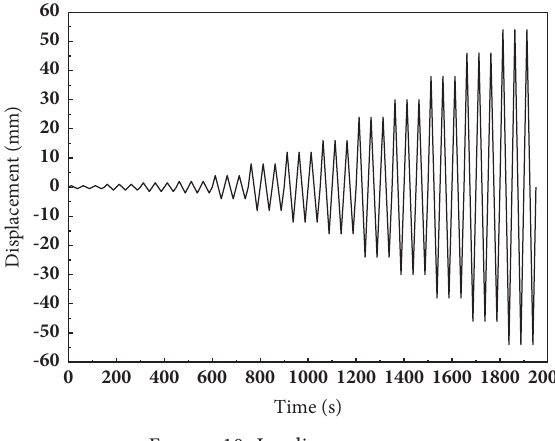
Figure 10: Loading program. Table 6: Material properties of